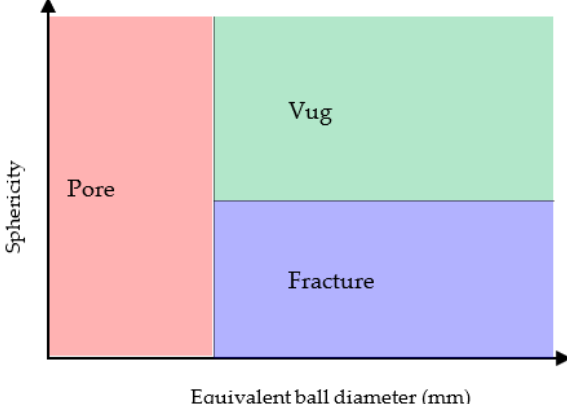
Figure 5. Classification criteria for pore, fracture, and cavity.